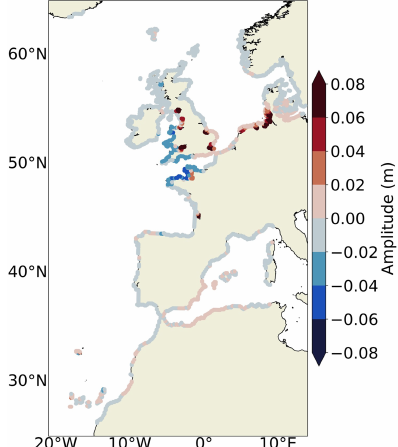
Figure 18. Projected changes of the M2 tidal amplitude for the SSP5-8.5 scenario between 2081–2100 and 1986–2005 period in